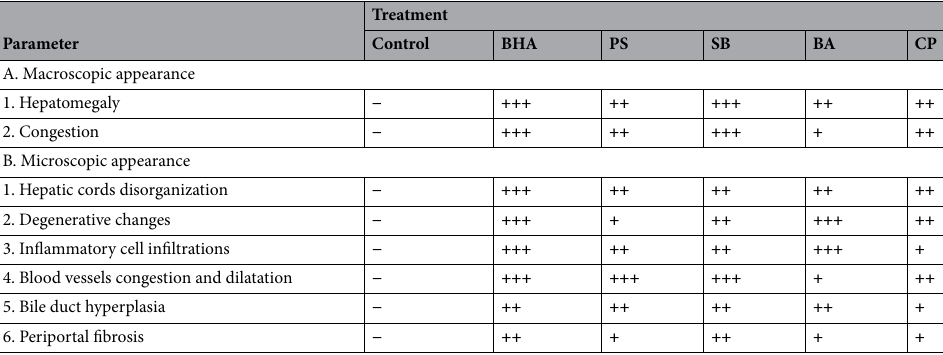
Table 3. The lesion scoring of hepatic tissues of butylated hydroxyl anisole (BHA), potassium sorbate (PS), sodium benzoate (SB), boric acid (BA), or calcium propionate (CP)-treated rats. Control group: received distilled water. BHA group: 0.09 mg/kg b.wt. PS group: received 4.5 mg/kg b.wt. SB group: received 0.9 mg/kg b.wt. BA group: received 0.16 mg/kg b.wt. CP group: received 0.18 mg/kg b.wt. Rats were orally given all food preservatives for 90 days. −: Absence of lesion; +: Mild; ++: Moderate; +++: Severe damage. N = 10/each